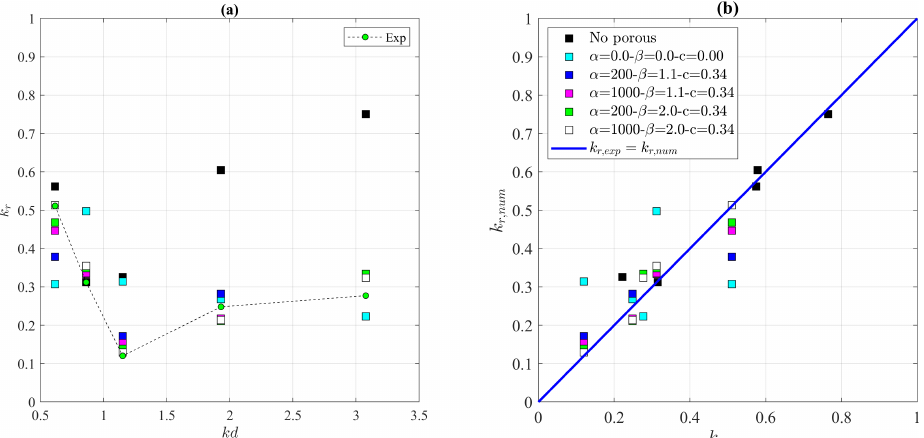
Figure 10. Comparison between the reflection coefficient estimated from the experimental data and that estimated from the numerical model: ( a ) reflection coefficient as a of function kd ; ( b ) experimental data vs. numerical